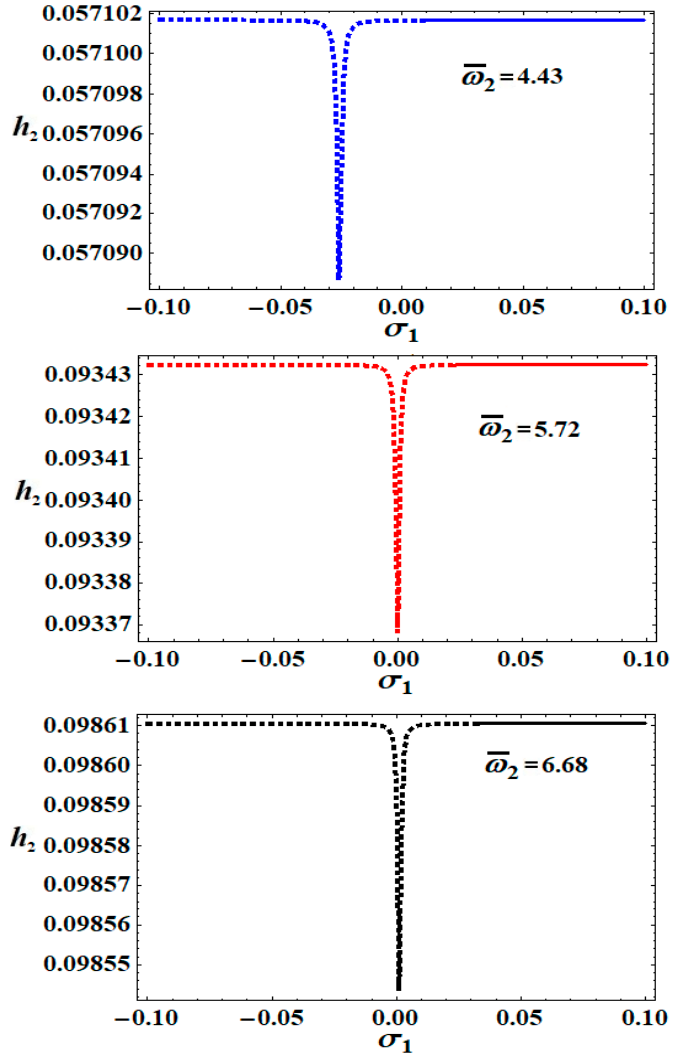
Figure 13. The variation of the frequency response h 2 with σ 1 at σ 2 = 0, σ 3 = 0 when ω 2 = ( 4.43, 5.72,6.68)